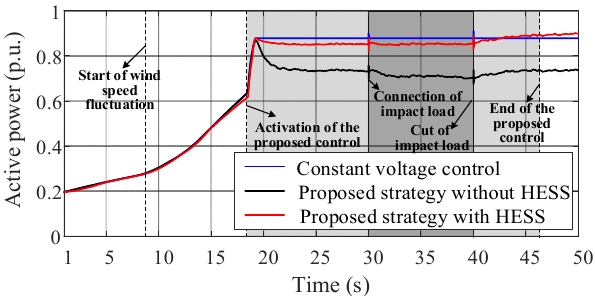
Figure 26. The output active power of the wind farm in case II.